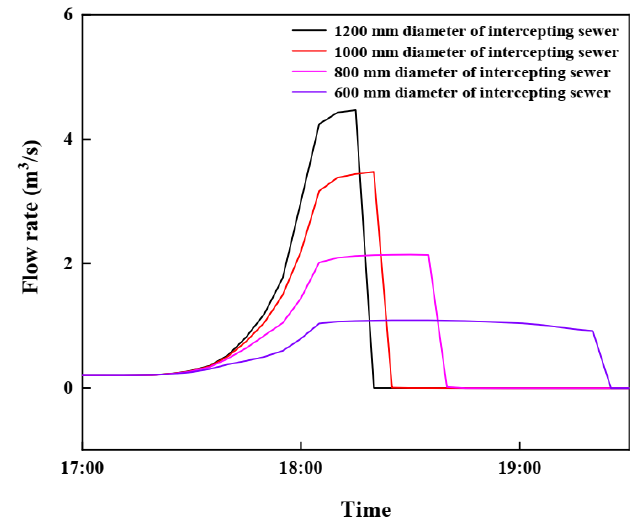
Figure 6. The optimization of pipe diameter.